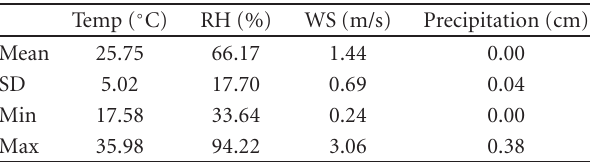
Table 3: Statistical characteristics of hourly averaged meteorologi- cal